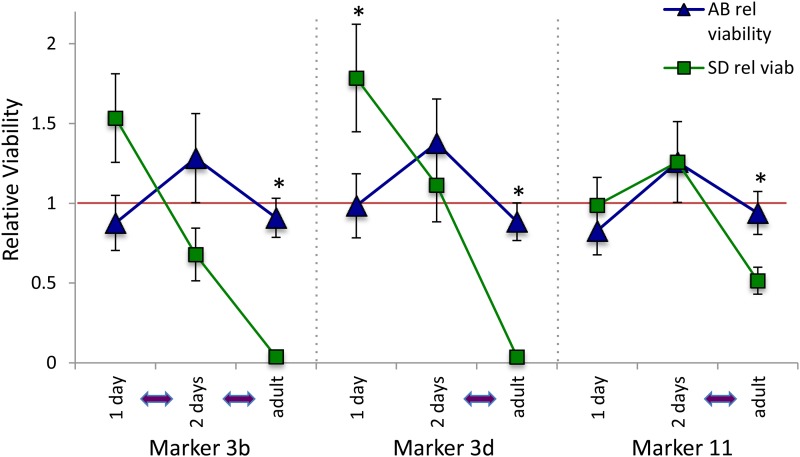
First and second day F2 hybrid nauplii relative viabilities. F2 hybrid nauplii and adults were collected from the SDf × ABm cross (DA2) of T. californicus populations, and genotyped for the PCR-based markers 3b, 3d, and 11. The red line again indicates the expected relative viabilities of one. An asterisk indicates a marker where genotypes differ significantly from the expected 1:2:1 ratio (P < 0.01 corrected P-value after applying a Bonferroni correction for five tests with α = 0.05 and 2 d.f.). Purple arrows indicate time periods over which there was a significant difference in genotypic ratios. Note that the 1–2 d period for marker 3d was approaching significance as well (P = 0.036). Tabular results are in Table S6.